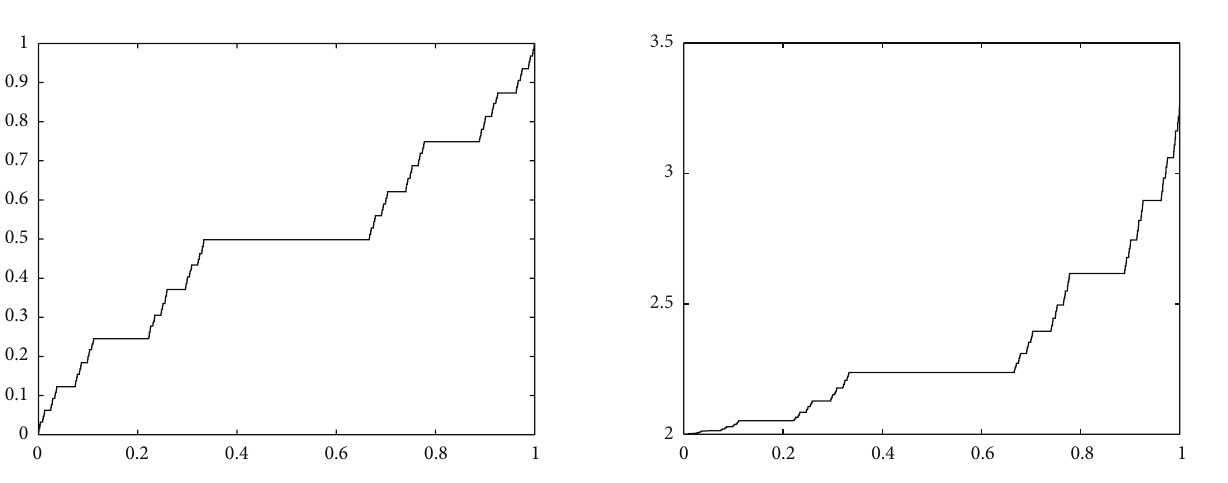
Figure 1: The Cantor function.